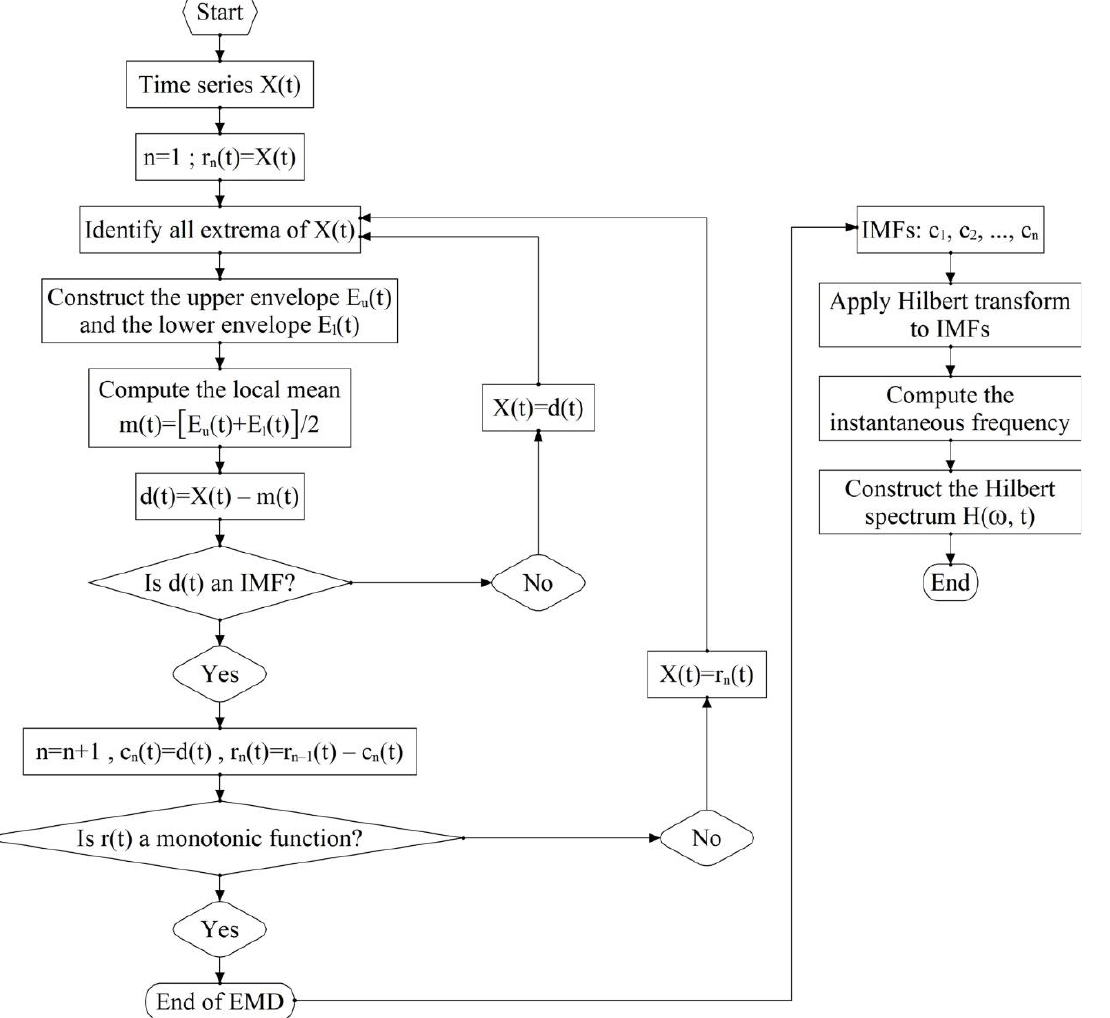
Figure 1. Flowchart of Hilbert – Huang Transform (HHT) Analysis.